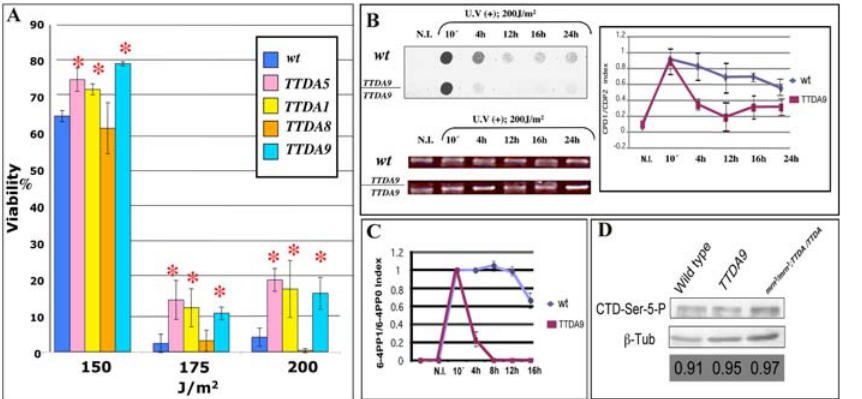
Figure 5. Viability, CPD and 6,4-PP repair rates, and CTD phosphorylation analysis in Dmp8/TTDA transgenic and wild-type lines after exposure to different doses of UV-B irradiation. (A) Third instar larvae were irradiated and then allowed to develop to adults. Survival rate is indicated for each strain. The graph represents the results of at least three independent dose-response experiments for each genotype. The statistical analysis by ANOVA indicates a P value , 0.001 for the more UV-resistant transgenic lines (TTDA5, TTDA1 and TTDA9) compared to the wild- type strain. The asterisks indicate significant differences compared to the wild type. Transgenic lines overexpressing Dmp8/TTDA are denoted as TTDA1, 5, 8 and 9. (B) Representative Southwestern dot-blot analysis using an anti-CPD antibody against genomic DNA extracted at different times from wild-type and Dmp8/TTDA transgenic third instar larvae after UV-B irradiation at 200 J/m 2 . N.I. denotes non-irradiated DNA. The quantification of three independent Southwestern experiments is represented as a plot in which the average signal value for each sample at different times is shown relative to the signal value obtained 10 min after UV irradiation (normalized to one). The amount of DNA loaded on each dot blot was visualized in ethidium bromide stained agarose gels. Different times are indicated. (C) Quantification of 6-4PPs by ELISA assays using an anti-6-4PP–specific antibody. Three independent DNA samples derived from wild-type and transgenic third instar larvae irradiated at 200 J/m 2 were analyzed in a typical ELISA assay. The average for each sample value is shown as the signal at different times relative to the value of the signal obtained 10 min after UV irradiation (normalized to one). (D) CTD-Ser-5 phosphorylation levels in different Drosophila lines. Total protein extracts from wild type, transgenic and rescued flies were analyzed in western blot experiments using an antibody that recognize the phosphorylated Serine 5 at the CTD domain of the RNA polymerase II large subunit (indicated in the figure as CTD-Ser-5-P). As internal loading control an anti- b -tubulin antibody was used. The phenotypes are indicated in the figure panel and the ratio between the CPD-Ser-5-P and b -tubulin signals are indicated at the bottom.